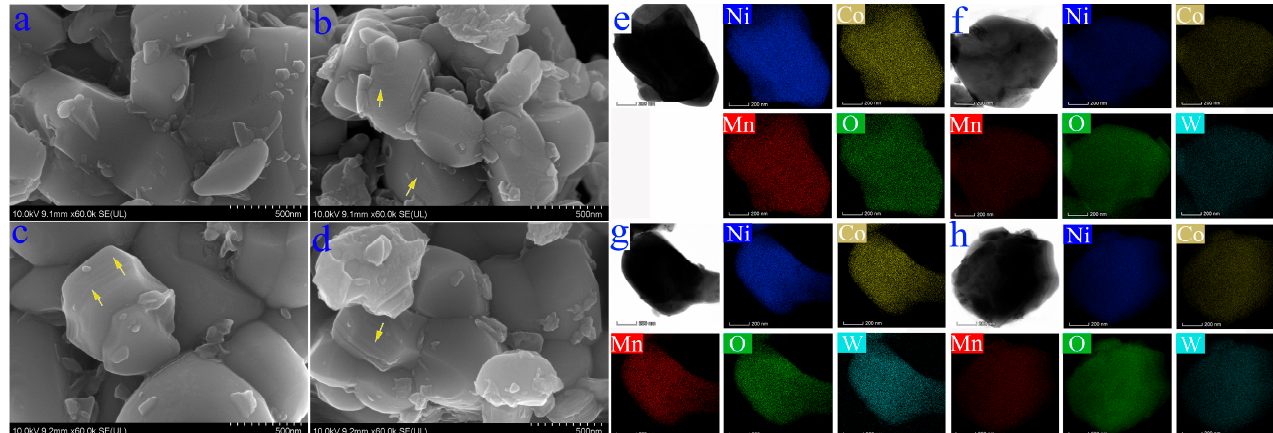
Figure 2. SEM, TEM images and EDS elemental mappings of ( a , e ) SC-NCM622, ( b , f ) SC-NCM622-0.5%WO 3 , ( c , g ) SC-NCM622-1.0%WO 3 and ( d , h ) SC-NCM622-1.5%WO 3 .